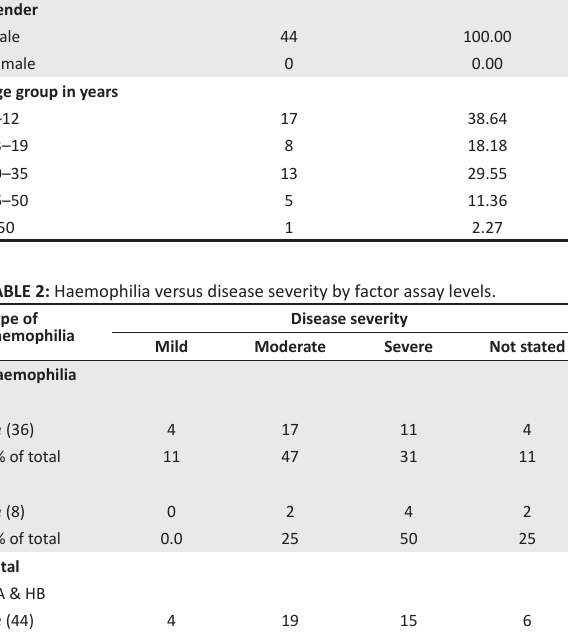
TABLE 1: Summary of demographics of patients with congenital haemophilia at Dr George Mukhari Academic Hospital. Study population ( n = 44)